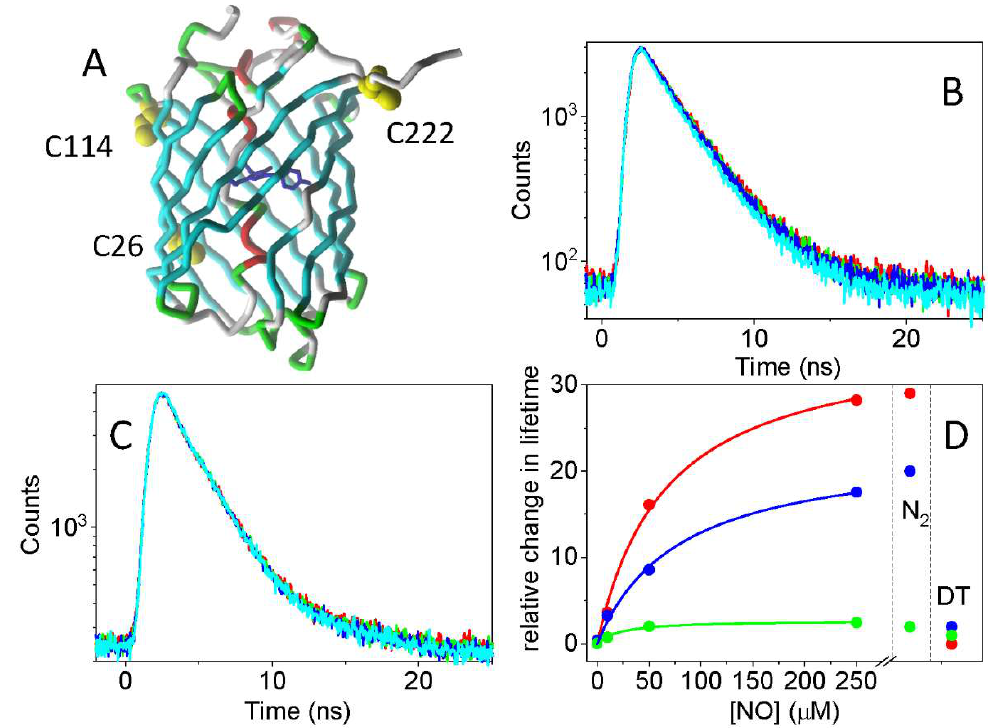
Figure 2. ( A ) Schematic representation of the three-dimensional structure of mTagBFP2, where C26, C114, and C222 are represented as yellow solid spheres, and the chromophore as blue sticks. ( B ) Fluorescence decays of (C26A) mTagBFP2 in PBS after deoxygenation with N 2 (red) and at different NO concentrations: [NO] = 10 µM (green), [NO] = 50 µM (blue), and [NO] = 250 µM (cyan). ( C ) Fluorescence decays of (C26A C114S C222S) mTagBFP2 in PBS after deoxygenation with N 2 (red) and at different NO concentrations: [NO] = 10 µM (green), [NO] = 50 µM (blue), and [NO] = 250 µM (cyan). After flowing N 2 for three hours (no change of fluorescence lifetime) and subsequent reduc- tion with Na dithionite, the initial signals were restored for both (C26A C114S C222S) mTagBFP2 and (C26A) mTagBFP2. ( D ) Percent change in average lifetime for mTagBFP2 (red circles), (C26A) mTagBFP2 (blue circles), and (C26A C114S C222S) mTagBFP2 (green circles). The data after N 2 equi- libration (N 2 ) and reduction with Na dithionite (DT) are reported as well. The solid lines are the result of the fits of the lifetime data with a model for binding a small ligand (NO) to the macromol- ecule.